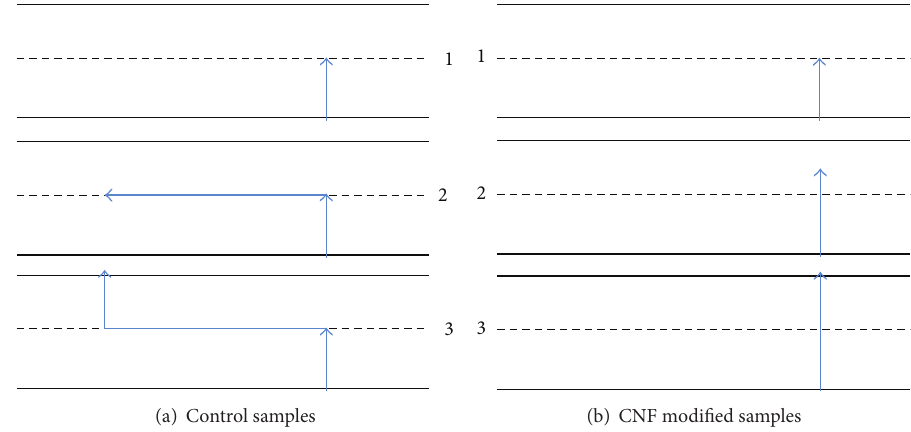
Figure 8: Damage development, as concluded by the presented evidence, of both the control samples (a) and the CNF modified samples (b). The development is presented in three steps. The control sample steps include: initial localized cross-sectional failure, delamination along the mid-plane, and final localized cross-sectional failure. The CNF modified samples experience only localized failure.